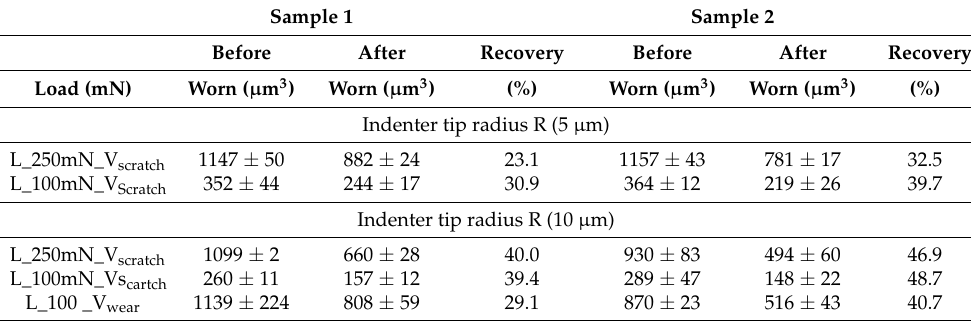
Table 3. Worn volume of scratches on samples 1 and 2 before and after annealing.